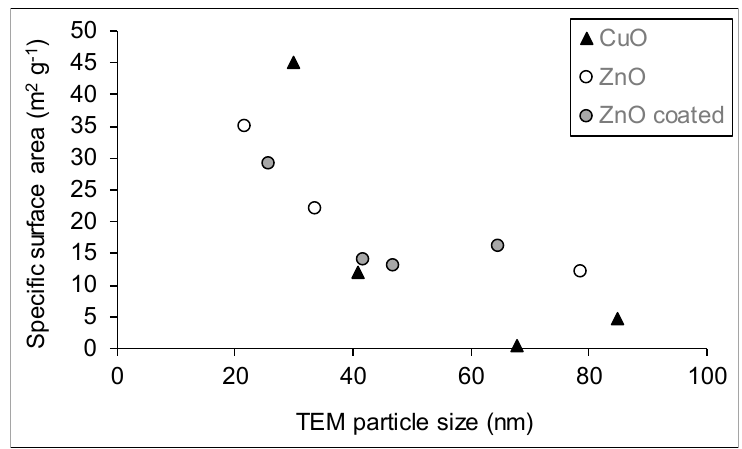
Figure 8. Relationships between the measured specific surface area and the particle size measured by TEM for CuO and ZnO nanomaterials: all CuO powders were uncoated; ZnO coated particles are described in Table 1.